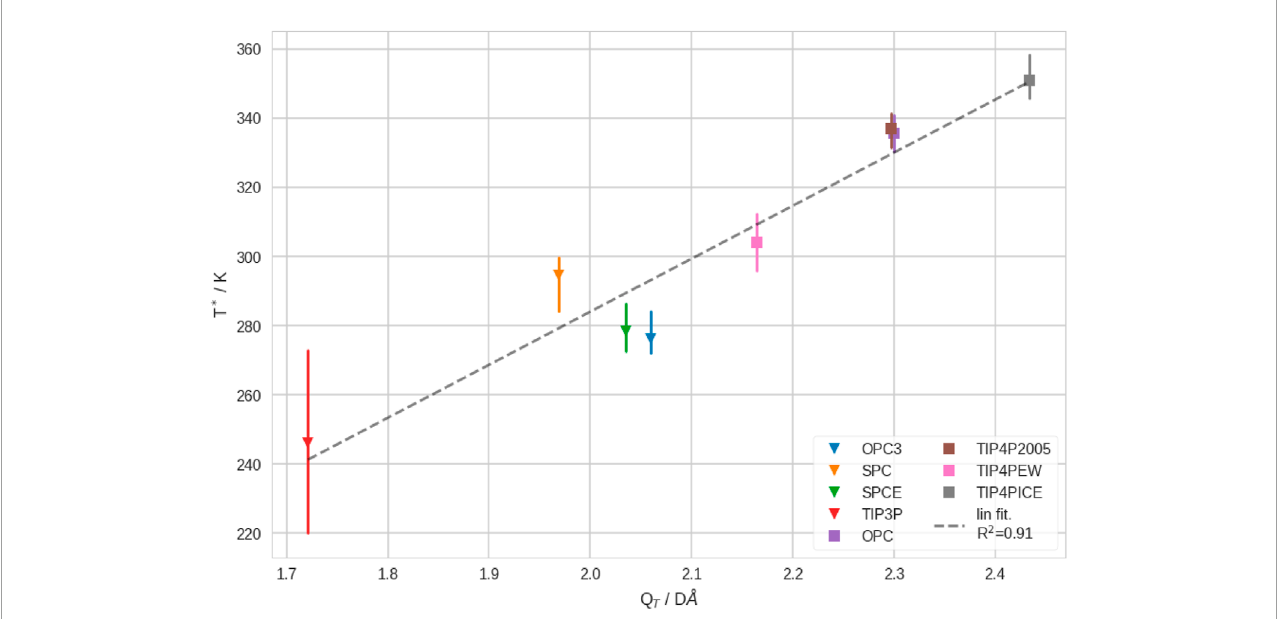
FIGURE 6 Transition temperature, T * , vs. the quadrupole moment, Q T , of different water models. We show the estimated mean and min./max. of T * , from leave-one-out cross-validation. Furthermore, we show 3-point water model as triangles and 4-point water models as squares. These results correspond to infinite